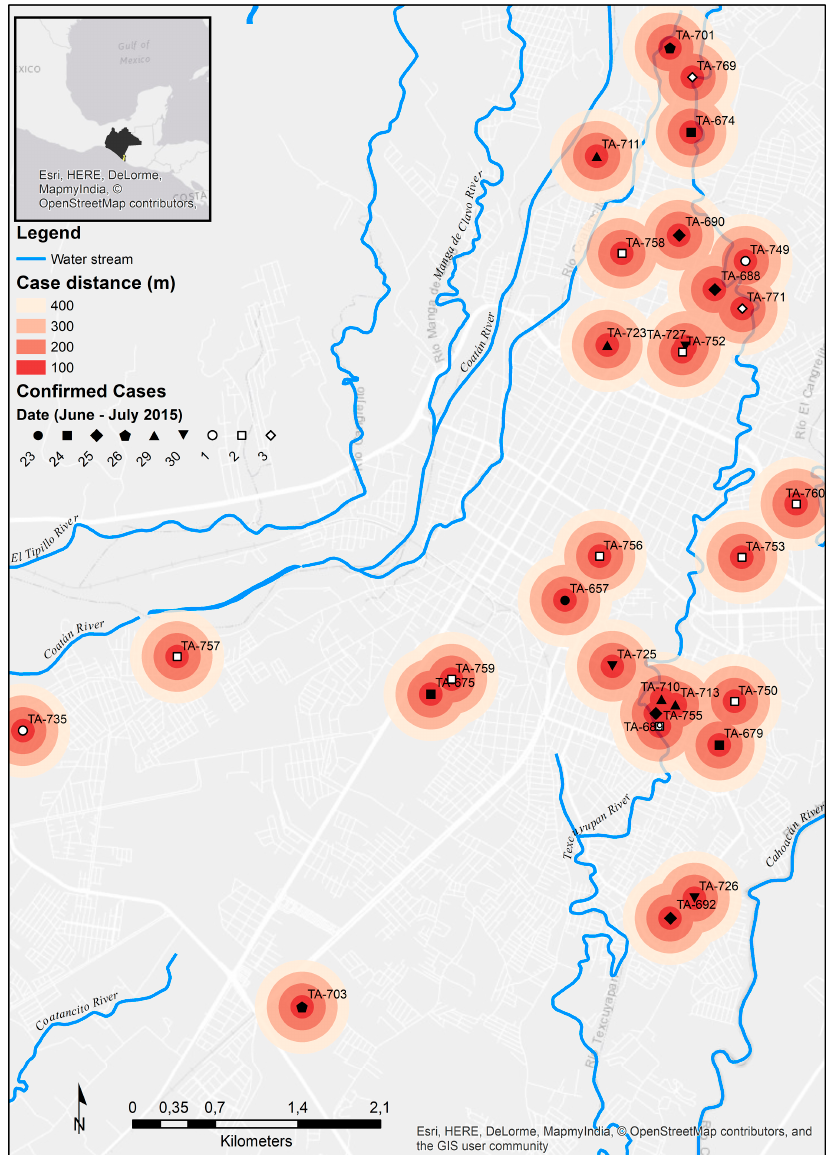
Figure 1. Distribution of confirmed Chikungunya fever cases in Tapachula, Chiapas. Chikungunya fever cases are marked. Concentric distance in meters is shown. The date of the patient’s enrolment is indicated. Patients enrolled in June and July are marked with a filled and hollow shape, respectively. The upper left square indicates the location of Tapachula municipality and Chiapas state. We used the World Light Gray Base by Esri (Esri Inc., Redlands, CA, USA) [41].